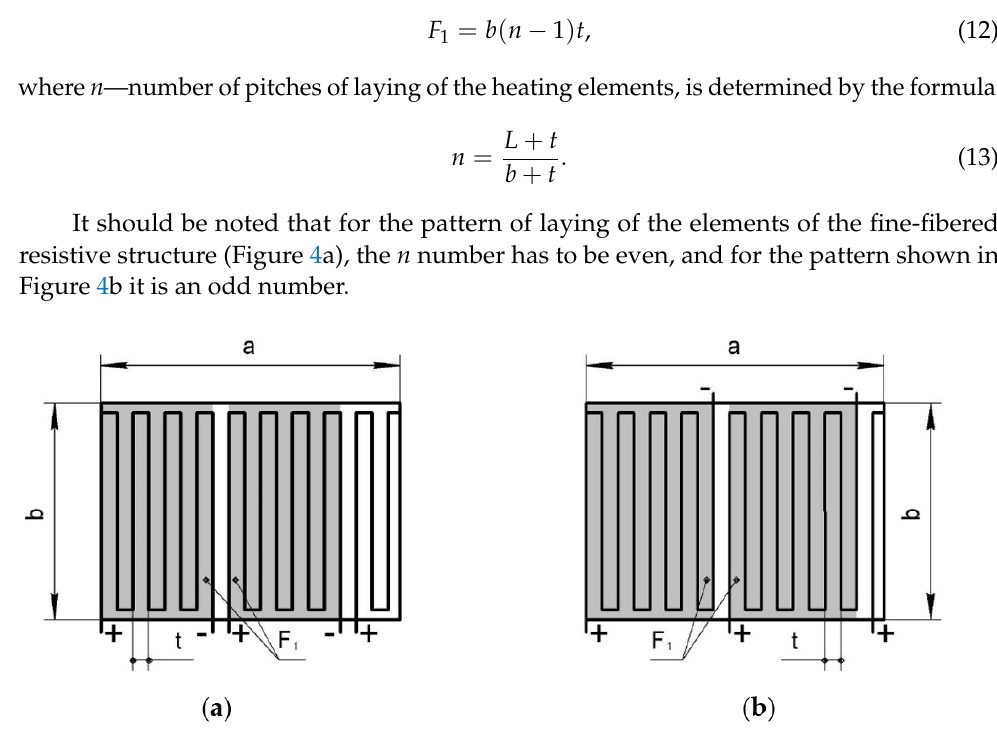
Figure 4. Patterns of laying for internal current sources ( a ) even number of pitches, ( b ) odd number of pitches.